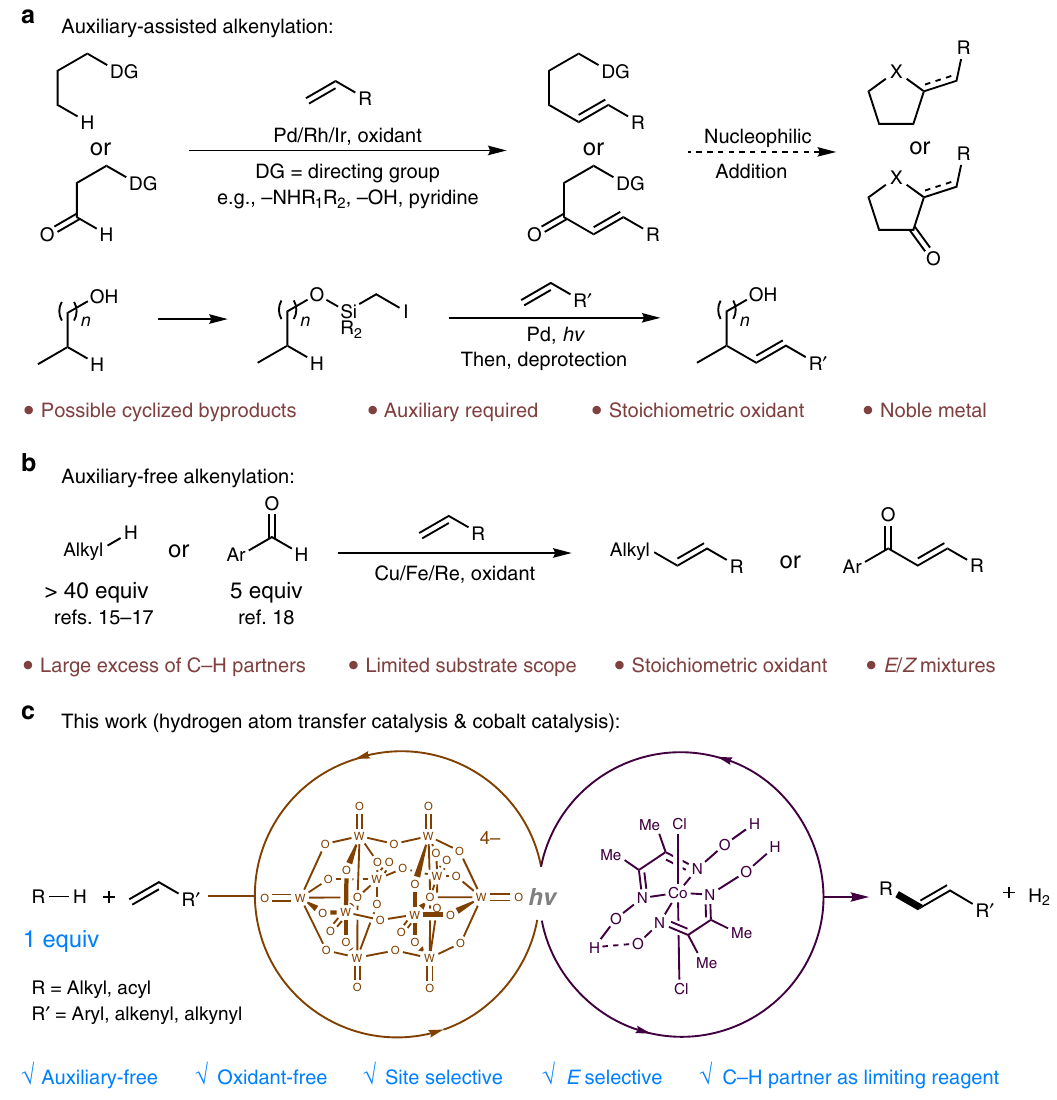
Fig. 1 Strategies for the dehydrogenative alkenylation of alkanes and aldehydes with alkenes. a Auxiliary-assisted alkenylation. b Auxiliary-free alkenylation. c Merging of a hydrogen atom transfer photocatalyst and a cobaloxime catalyst enables site-selective direct alkenylation of C – H